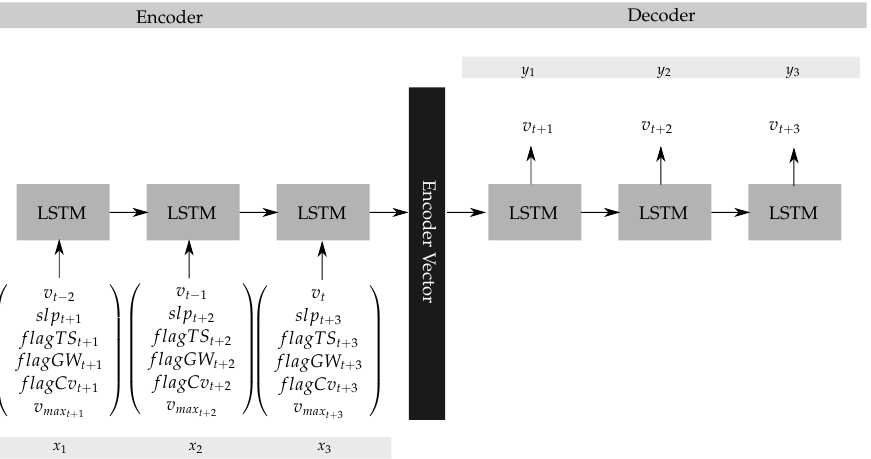
Figure 12. Architecture of the implemented ED-LSTM in multi-step, multivariate application for an exemplary prediction horizon of 3 s. The input data includes both past velocity timesteps ( v i ) and future information about slope ( slp i ), traffic signals ( flagTS i ), give way signs ( flagGW i ), curves ( flagCv i ) and the legal speed limit ( v max ). The output of the ED-LSTM represents the future velocity for the prediction horizon of 3 s. 309